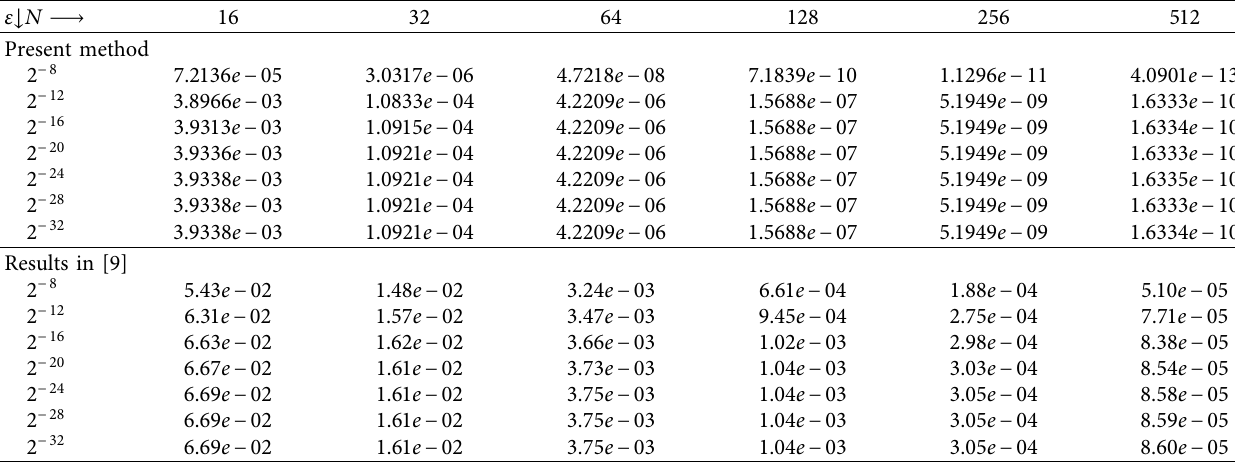
Table 2: Comparison of maximum absolute errors for Example